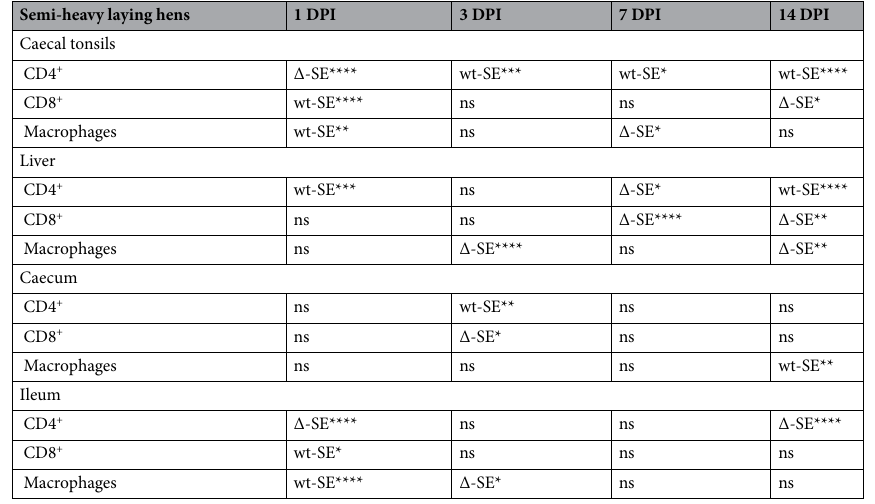
Table 2. Representation of the significant difference related to the quantitative distribution of different immune response cells in organs of semi-heavy laying hens infected with Salmonella Enteritidis wild and mutant strains at different days post-infection. DPI, days post-infection; ∆-SE, Salmonella Enteritidis ∆ ttr A∆ pdu A; wt-SE, Salmonella Enteritidis wild-type; ns, no significant difference. Within each organ and DPI, * means difference by two-way ANOVA followed by Bonferroni’s comparison test between wild and mutant strains values (*P ≤ 0.05; **P ≤ 0.01; ***P ≤ 0.001; ****P ≤ 0.0001). The strain presented in the table (∆-SE or wt-SE) as significant within the organ and DPI is that shown the major infiltration area to each cell.